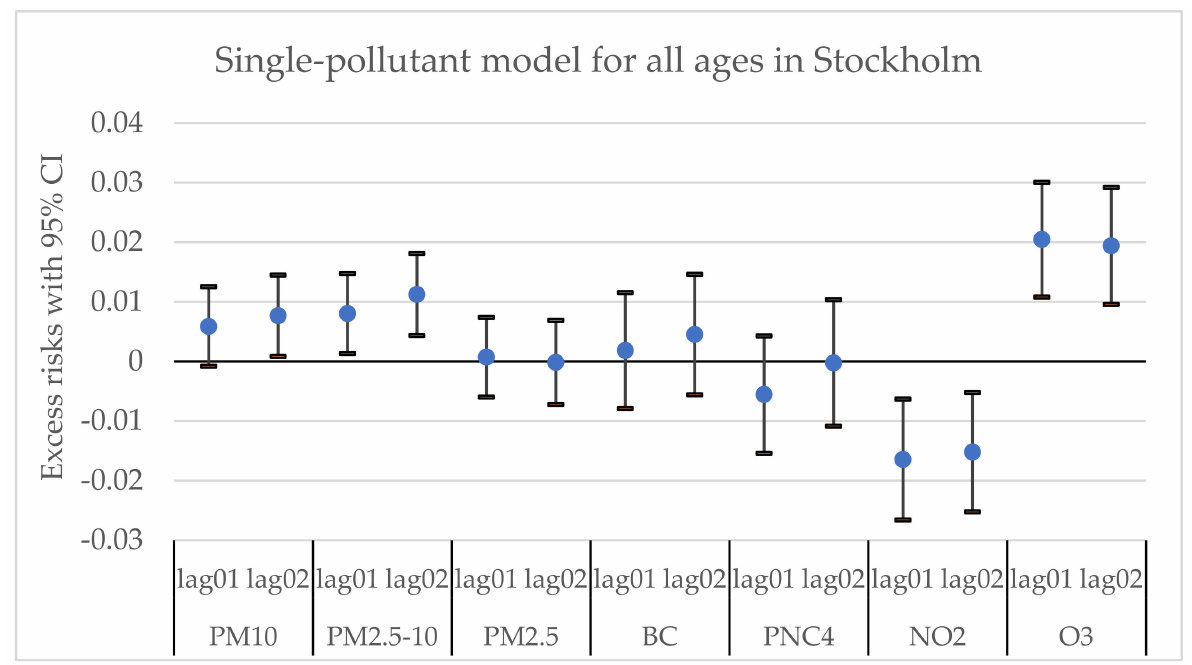
Figure A1. A single-pollutant model of the estimated change in daily mortality in all ages (with 95% CI) for an IQR increase in the concentrations (lag01 and lag02) of different air pollutants in